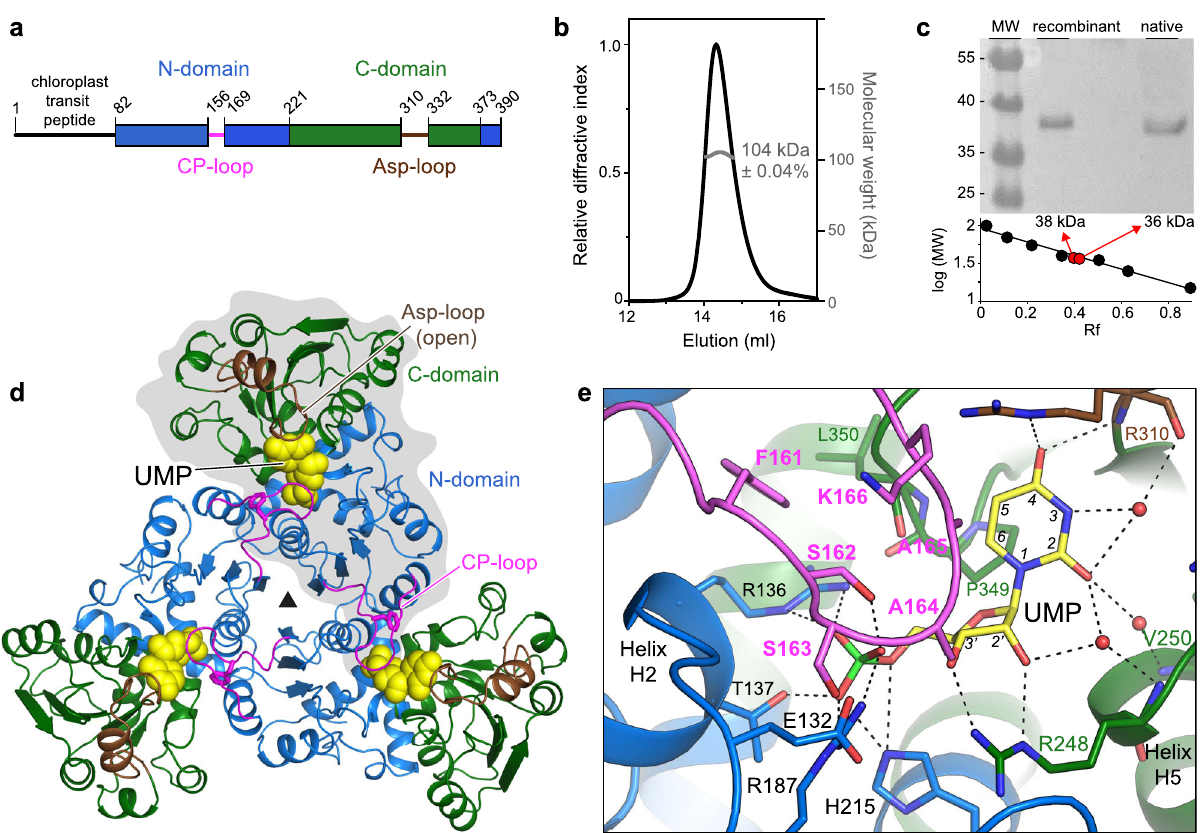
Fig. 2 Structure of Arabidopsis ATC bound to UMP. a Scheme of Arabidopsis ATC protein. b SEC-MALS analysis of puri fi ed atATC proves the formation of a homotrimer. c Immunoblot of atATC and mature ATC from leaf extract. The experiment was performed three times with identical results. d Crystal structure of atATC trimer with each subunit bound to one molecule of UMP (shown as yellow spheres). One subunit is shown on gray background. Protein domains are colored as in ( a ). e Detail of the active site with UMP bound. Water molecules are shown as red spheres. Electrostatic interactions are indicated as dashed